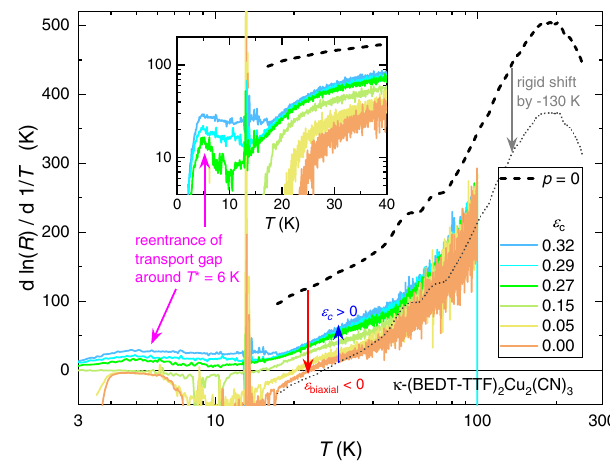
Fig. 3 | Fingerprints of Mott transition and ‘ 6K anomaly ’ in transport gap. The transport gap d ln R = d 1 = T determined from the strain-dependent resistance (Fig. 2c) is compared to ambient pressure (black dashed line from ref. 28). While biaxial compression ε biaxial <0 causes a reduction of the gap size, equivalent to a vertical shift of the p =0 data by − 130K (gray dotted), the gap increases upon tensilestrain ε c >0,consistentwiththebandwidth-tuninginFig.2b.TheMottMITis evident from the sign change at T BR . Upon further cooling in the metallic state, d ln R = d 1 = T ! 0astheresidualresistivityisapproached,followedbyasharpdrop when SC sets in. Notably, the fully insulating curves exhibit a local maximum around T ⋆ =6K associated with the VBS